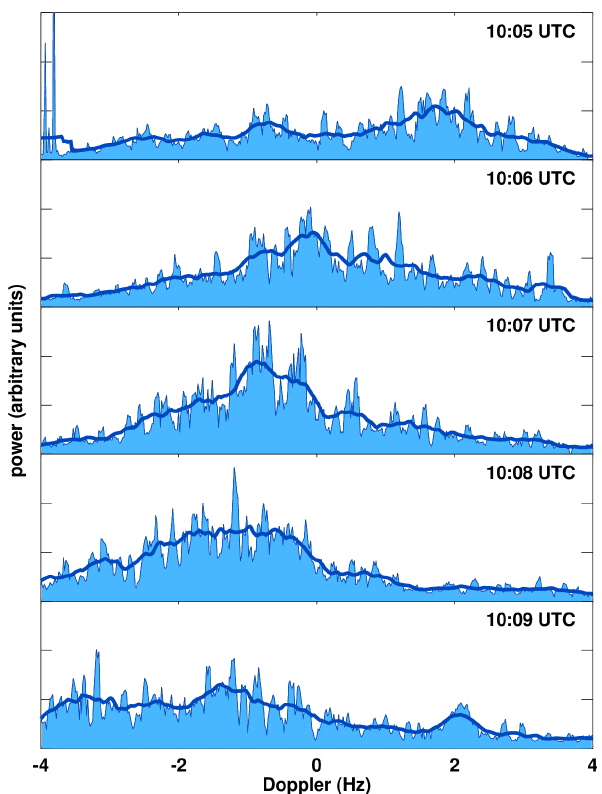
Figure 5. Movement of a perturbation in profiles of the power at the strongest detection range in each frequency bin (0.018Hz reso- lution) of PMSE detection for NSMR on 19 July 2020. Solid line is spectral power smoothed with a 0.5Hz